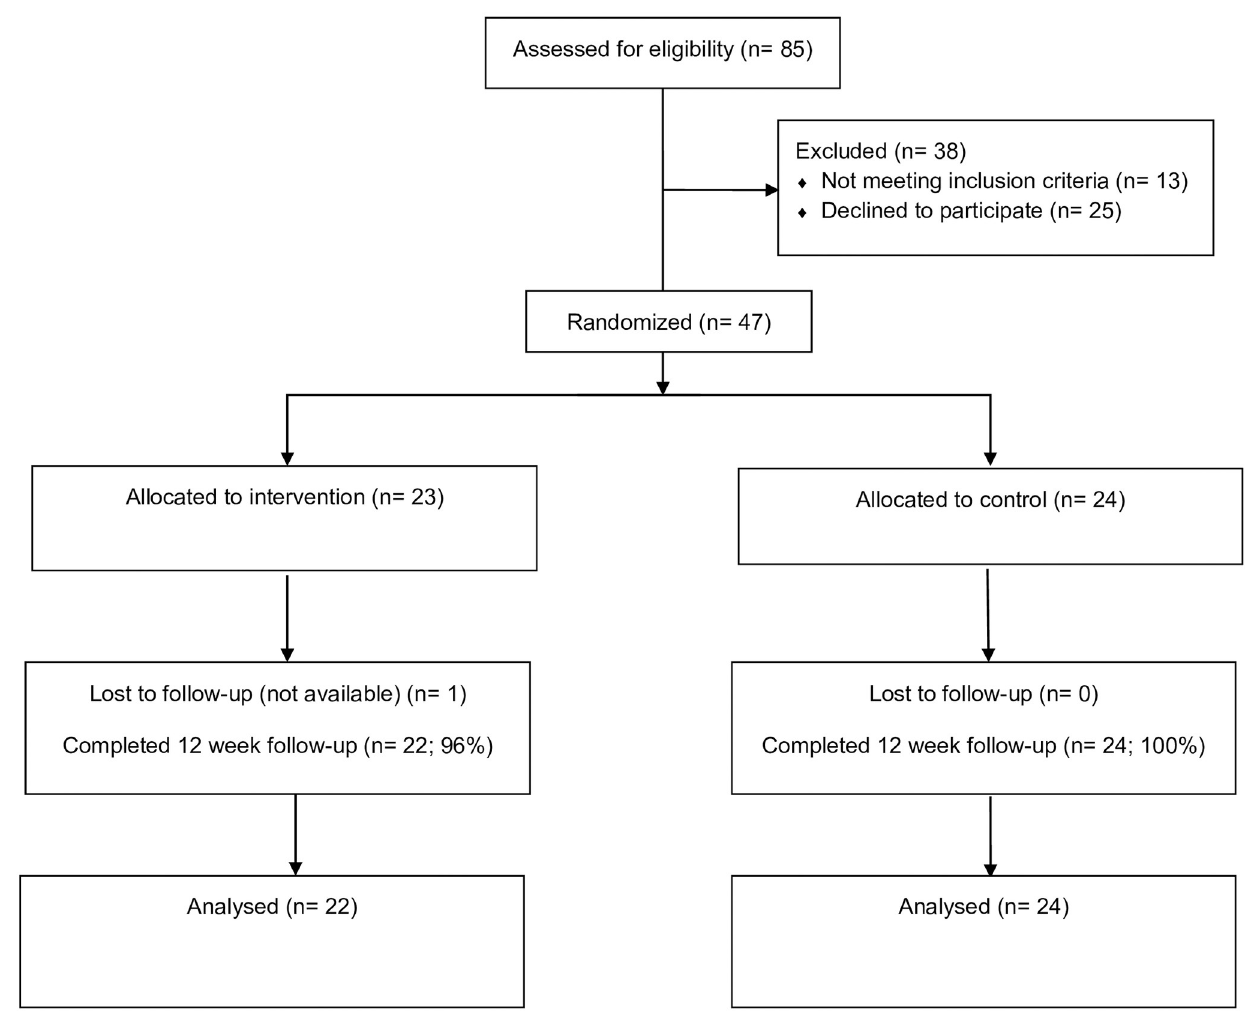
Fig 1. HIIT flow chart.